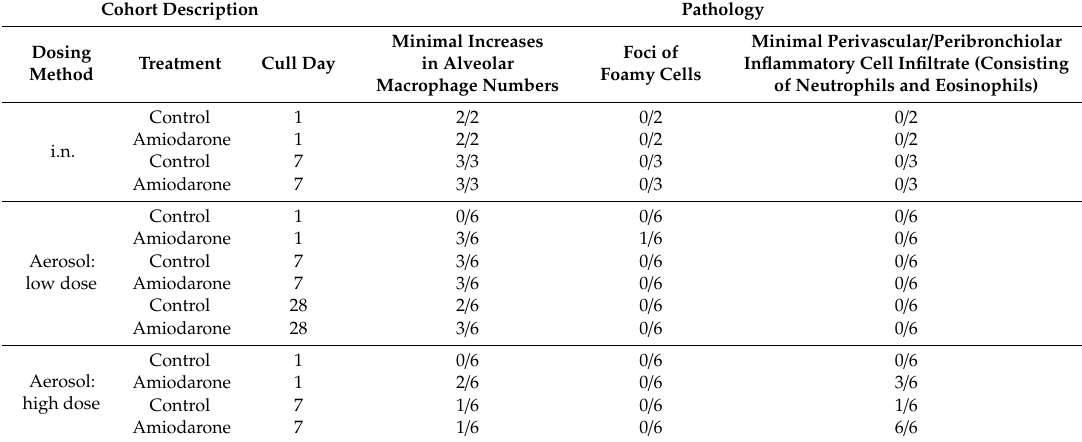
Table 1. Summary of pathology observations in study groups with an observed pathology. Groups with no pathology observations are not listed. Results depict the number of animals per cohort exhibiting the